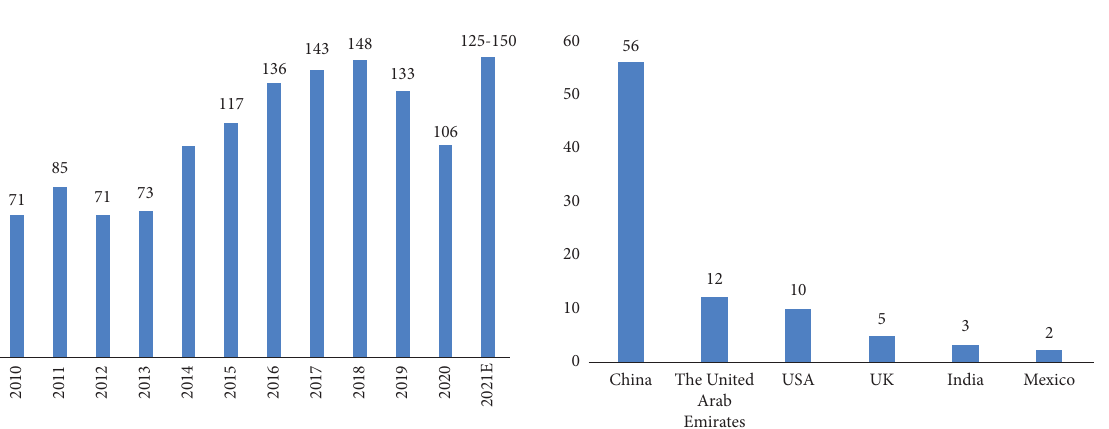
Figure 1: Statistical analysis of the development of the construction industry in 2010–2021 (2022). Source: National Bureau of Statistics (NBS) [6].